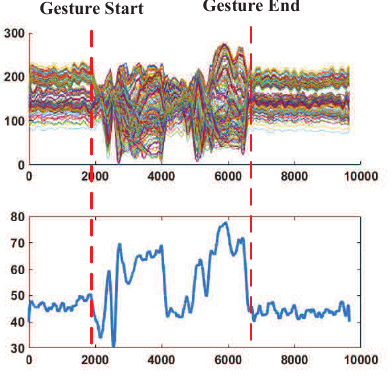
Figure 6. The average standard deviation of the gesture